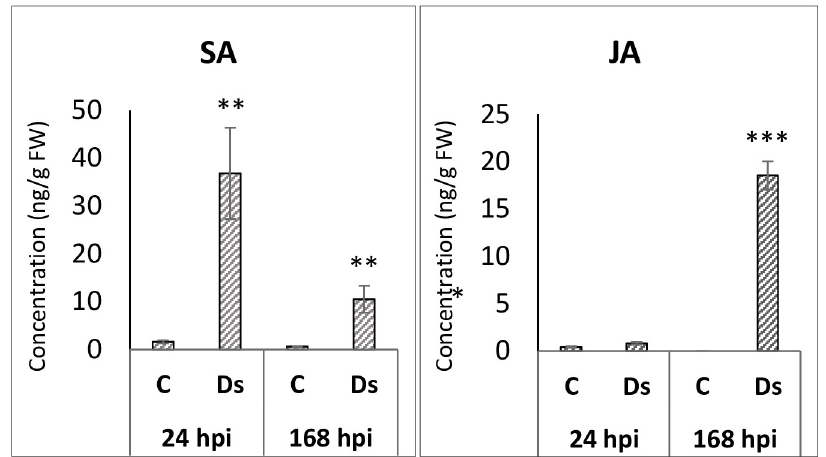
Fig 6. Salicylic acid (SA) and jasmonic acid (JA) concentrations in tubers inoculated with Dickeya solani and corresponding control tubers 24 h and 168 h post-inoculation (hpi). Changes in tuber phytohormone contents (ng/ g fresh weight) in controls (C) and inoculated tubers (Ds). Stars indicate significant differences in the t-test.